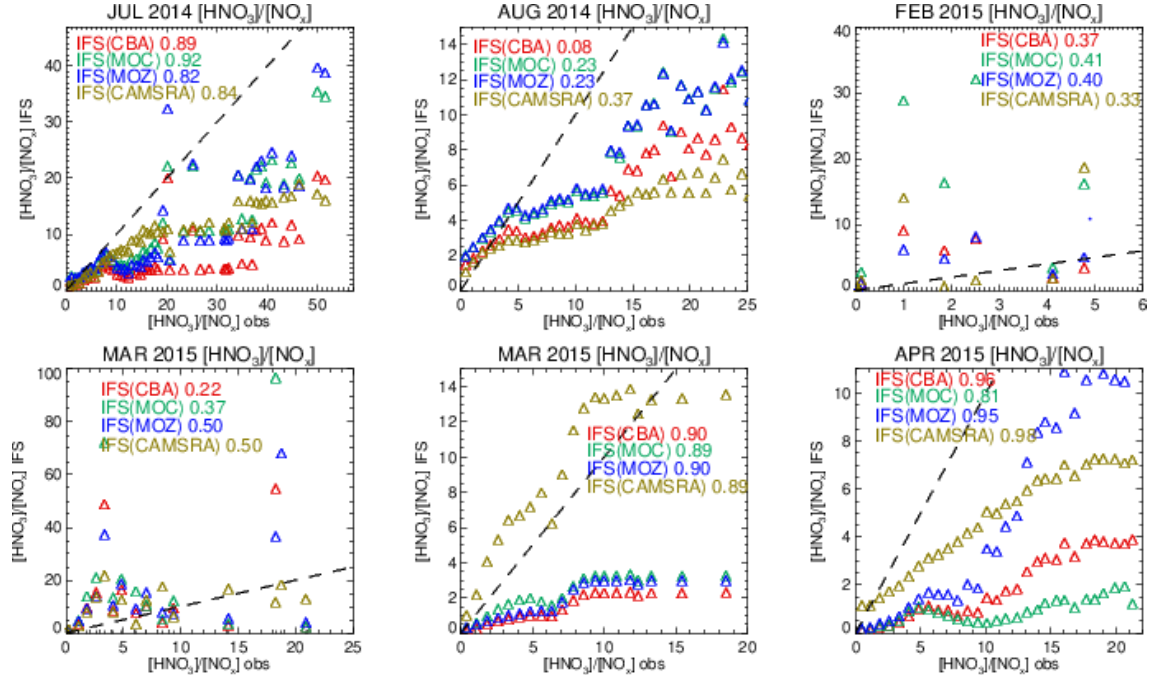
Figure 17. Comparisons of the observed [ HNO 3 ] / [ NO x ] ratio for selected months against the corresponding values from the ensemble members below 800hPa. The values are binned with respect to the observations using a bin width of 0.75 with respect to [ HNO 3 ] / [ NO x ] and the correlation coefficients provided in each panel. Measurements are taken from FRAPPE, WINTER and SONGNEX campaigns to cover seasonality and